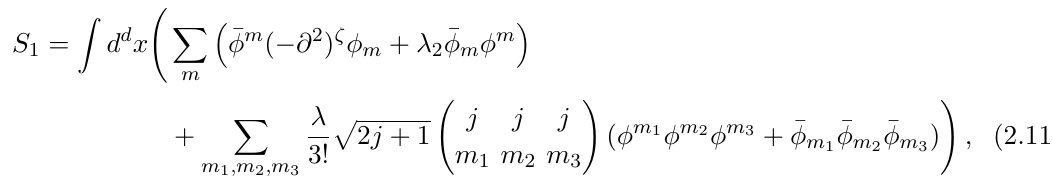
for N = (2 j + 1) → ∞ , with α 0 > 0 . As three-valent fully 2PR diagrams are equivalent